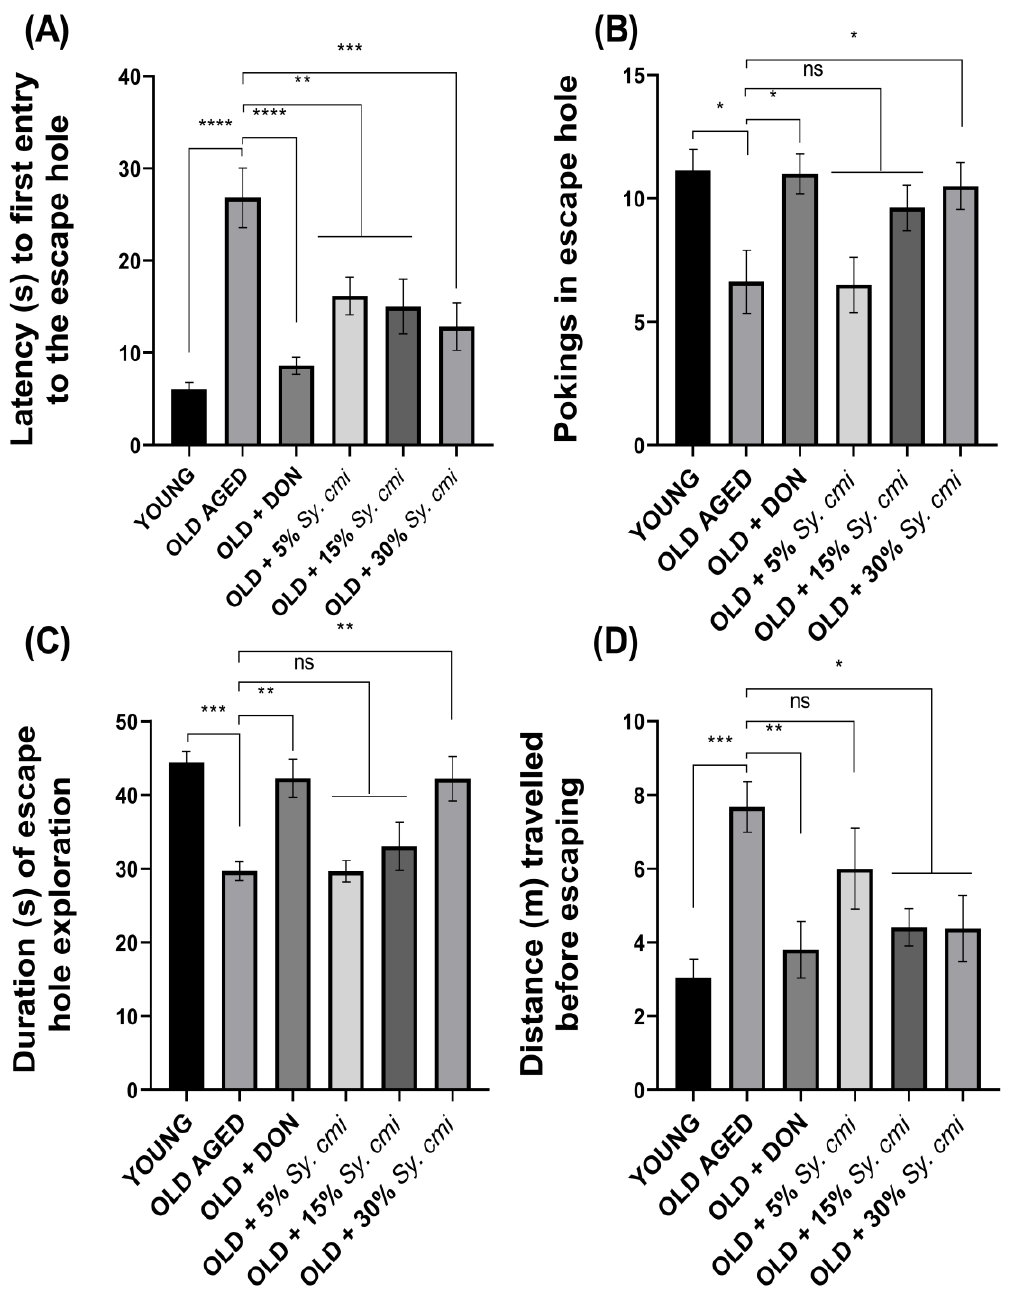
Figure 9. The mice ( n = 8) supplemented with 5, 15, and 30% dilutions of Sy. cmi for 16 months were tested for learning and memory in the Barnes maze test, and the animals’ cognitive ability was tested by monitoring their remembrance of the escape box location on the probe day to note ( A ) latency to first entry in escape hole, ( B ) pokings in escape hole, ( C ) duration of escape hole exploration, and ( D ) distance travelled before escaping, time in escape hole the latency to enter the escape hole. The outcomes of all groups were compared with the aged control group and * p < 0.05, ** p < 0.01, *** p < 0.001, **** p < 0.0001 were considered statistically significant while ns showed non-sgnificant outcomes for all data presented as mean ± SEM.